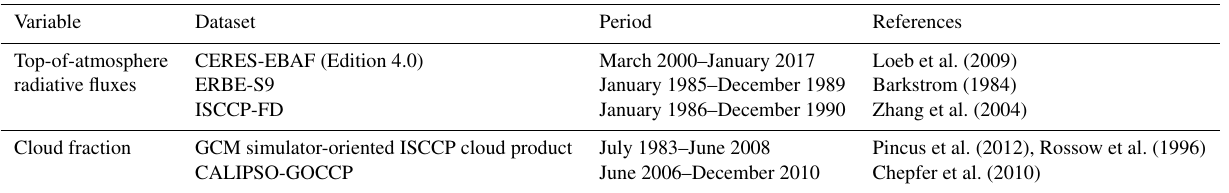
Table 2. Observation data used for the model evaluation. All data are monthly